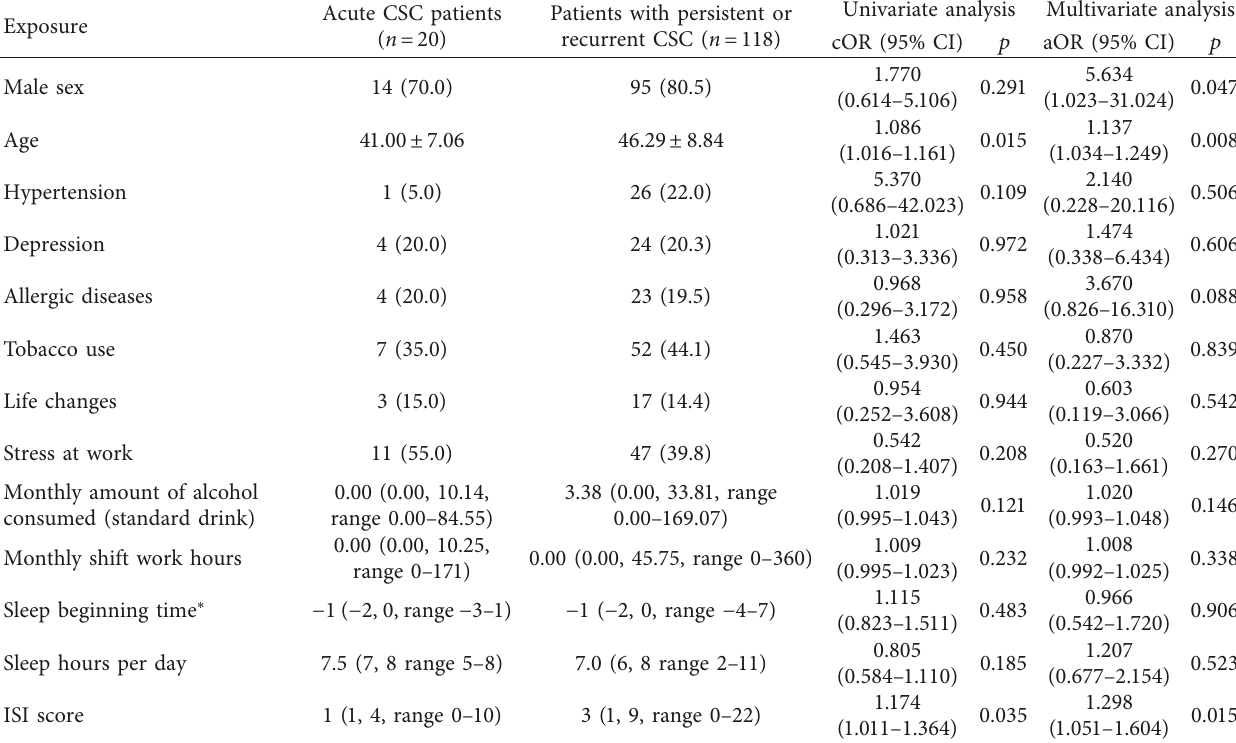
Table 1: Demographic and clinical data and univariate and multivariate analysis of risk factors for persistent or recurrent central serous